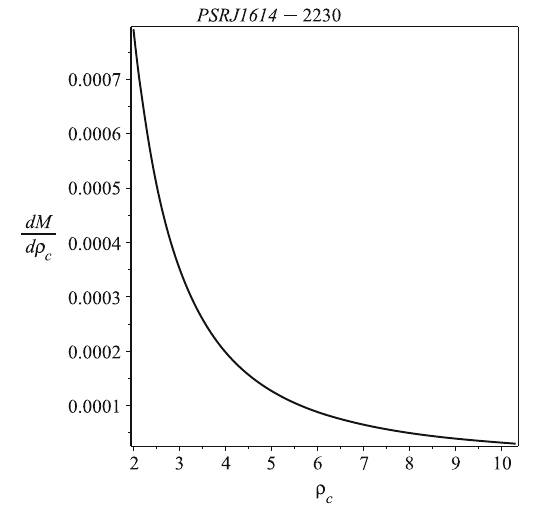
w.r.t. ρ c for the strange star candidate d ρ c